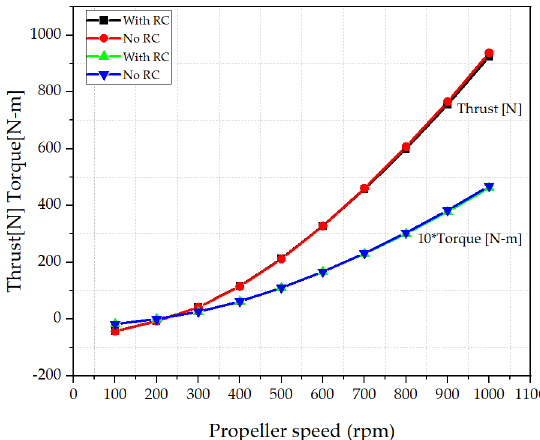
Figure 23. Thrust force [N] and 10×Torque [N-m] analysis on the propeller walls.